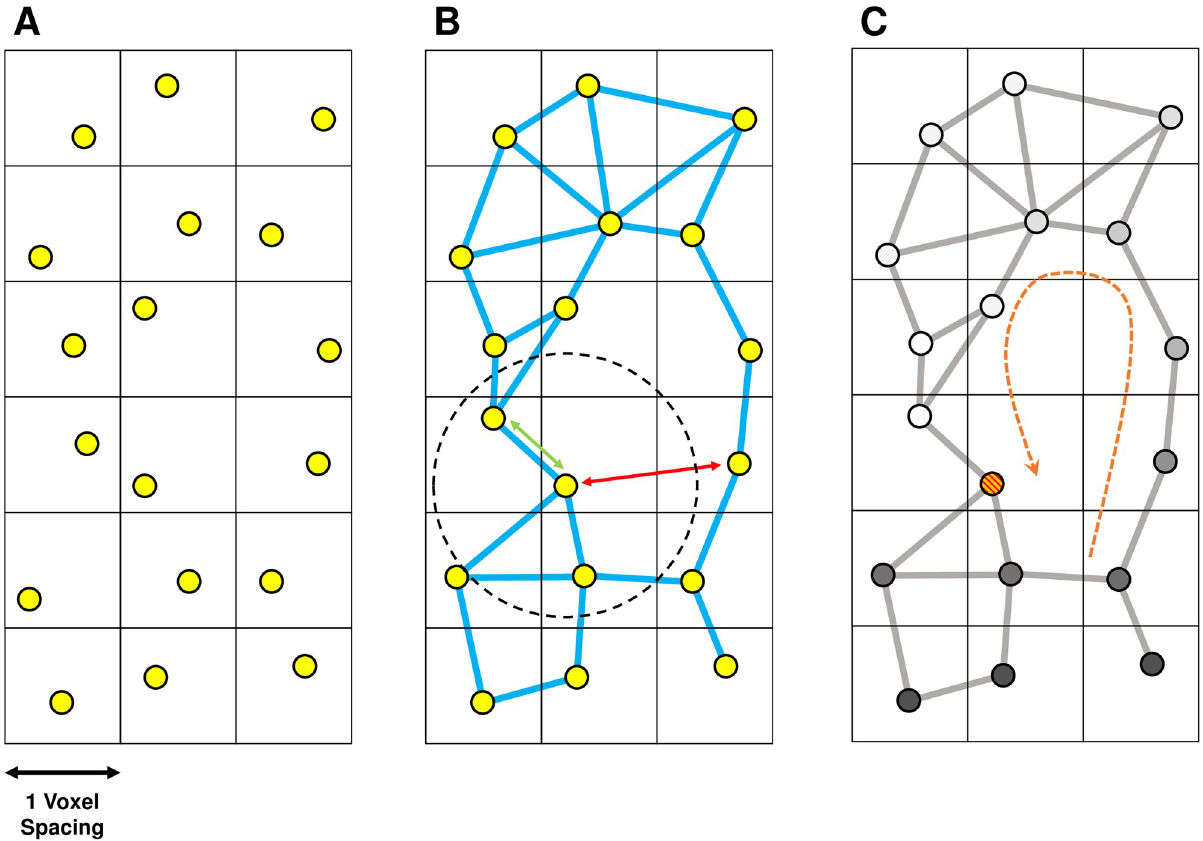
Fig 4. A 2d schematic demonstrating the construction of the spatial network using the fibre-less null model. The process is similar to Fig 3 where steps (A) and (B) are skipped. (A) Nodes are distributed uniformly in each voxel. (B) Nodes are connected according to a monotonically decreasing function of distance, p ( x ; r , c ), Eq (1), where c is a characteristic distance (dashed circle). There is no directional bias in the connection probability (blue edges only). Nodes which are closer together than the characteristic distance (green arrows) are more likely to be connected than those which are far apart (red arrows). (C) The micro-reentrant substrate is identified using the DDM.